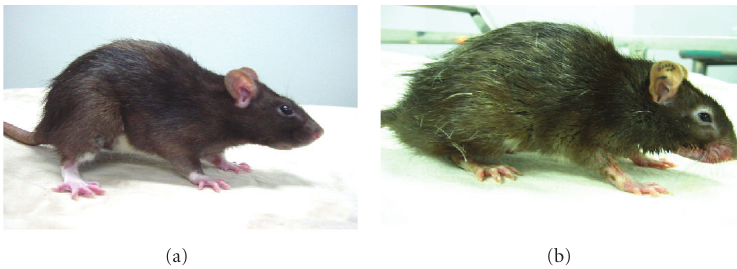
Figure 2: Clinical signs and pathological findings of aGVHD after liver transplantation. (a) In group 2, the appearance of the recipient returned to normal 2 weeks after transplantation. (b) On the 16th day after liver transplantation, (LewisXBN)F1 recipients in group 4 showed typical clinical signs of aGVHD, including di ff use alopecia (especially around the ear, eye, and food), severe athrepsy, hunched posture, and obvious